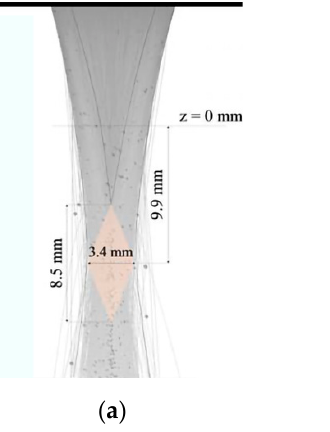
Figure 13. Focal plane position for ( a ) Ti6Al4V and ( b ) 316L powder (reproduced with permission from [73]; Copyright © 2012 COMSOL).